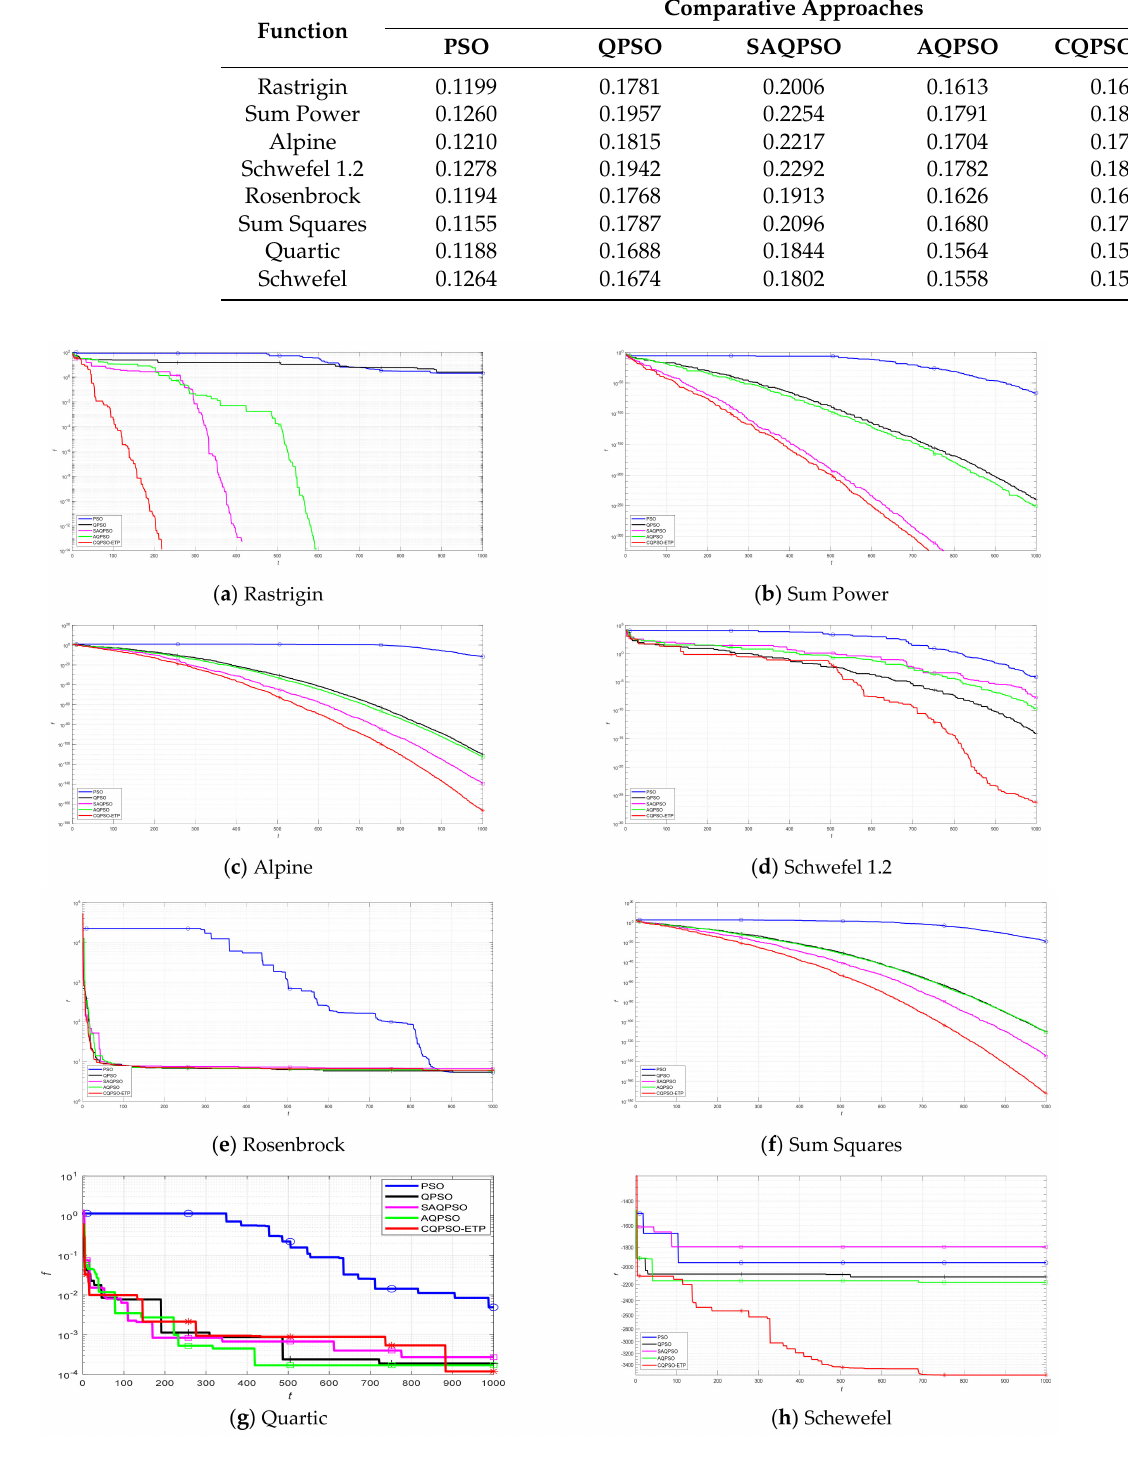
Figure 6. Convergence of the comparative approaches on eight numerical benchmark functions ( D =